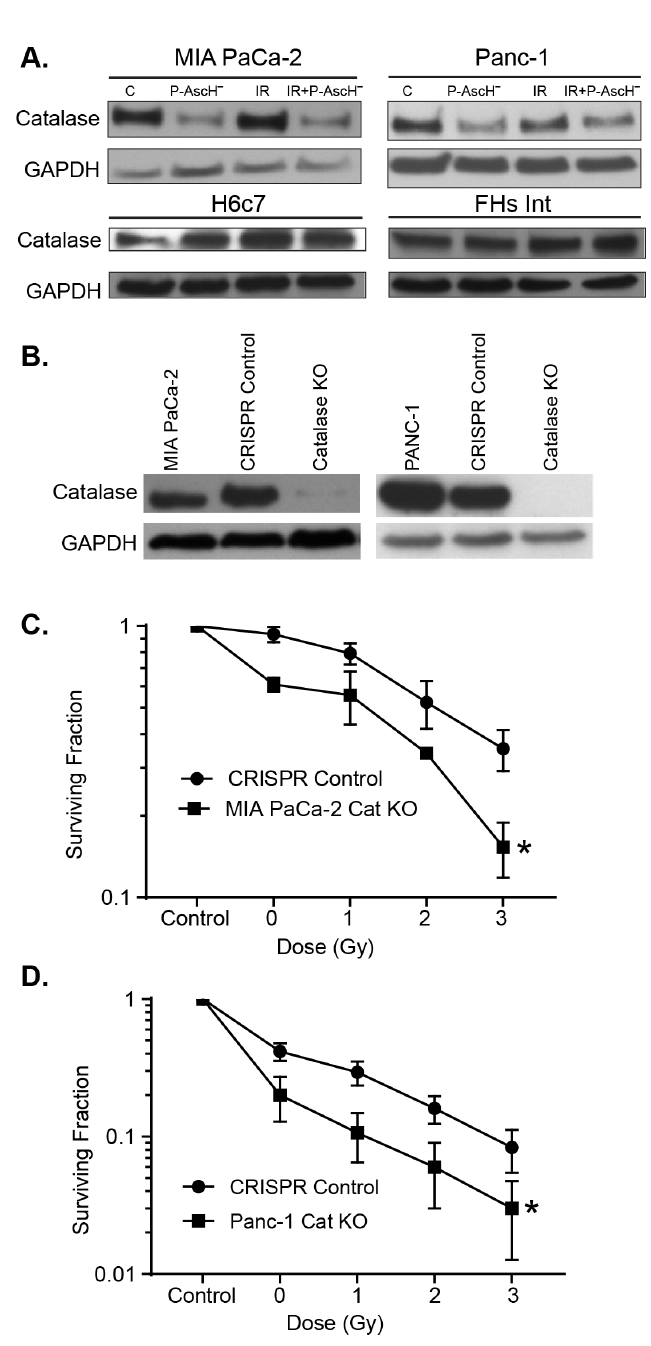
Figure 4. Cellular catalase blunts the radio-sensitization of P-AscH − . ( A ) The PDAC cell lines MIA PaCa-2 (5 pmol cell − 1 , 1 mM) and PANC-1 (15 pmol cell − 1 , 3 mM), and the non-tumorigenic H6c7 and FHs74Int cell lines were treated with P-AscH − (5 pmol cell − 1 , 1 mM) with and without IR (5 Gy). Live cells were collected and Western blots performed to determine catalase immunoreactive protein. P-AscH − alone and in combination with radiation, decreased catalase in the PDAC cell lines, but not in the H6c7 or FHsInt cell lines; ( B ) clones of MIA PaCa-2 and PANC-1 PDAC cells subjected to CRISPR/Cas9 catalase genome editing demonstrate decreased expression of catalase; ( C ) genetic inhibition of catalase expression radio-sensitized MIA PaCa-2 cells to treatment with P-AscH − (5 pmol cell − 1 , 1 mM) (means ± SEM, * p < 0.05 vs. CRISPR control, n = 3); ( D ) genetic inhibition of catalase expression radio-sensitized PANC-1 cells to treatment with P-AscH − (10 pmol cell − 1 , 2 mM,) (means ± SEM, * p < 0.05 vs. CRISPR control, n = 4).